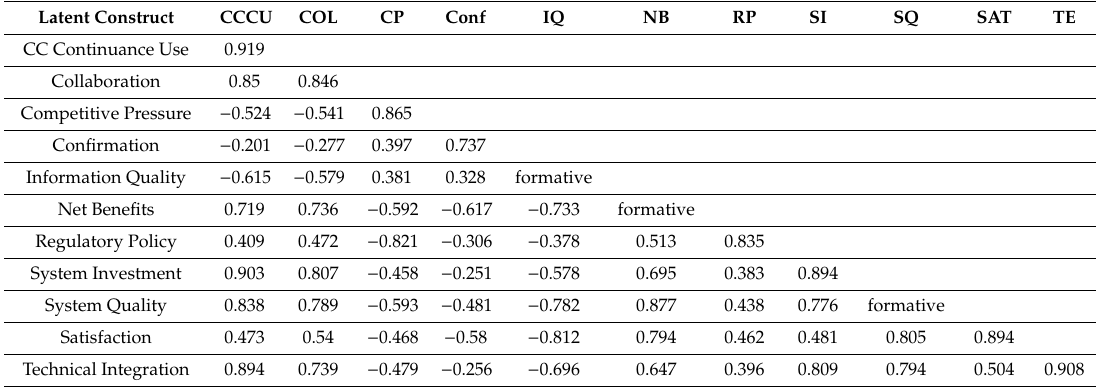
Table 7. Discriminant Validity (Fornell-Larker